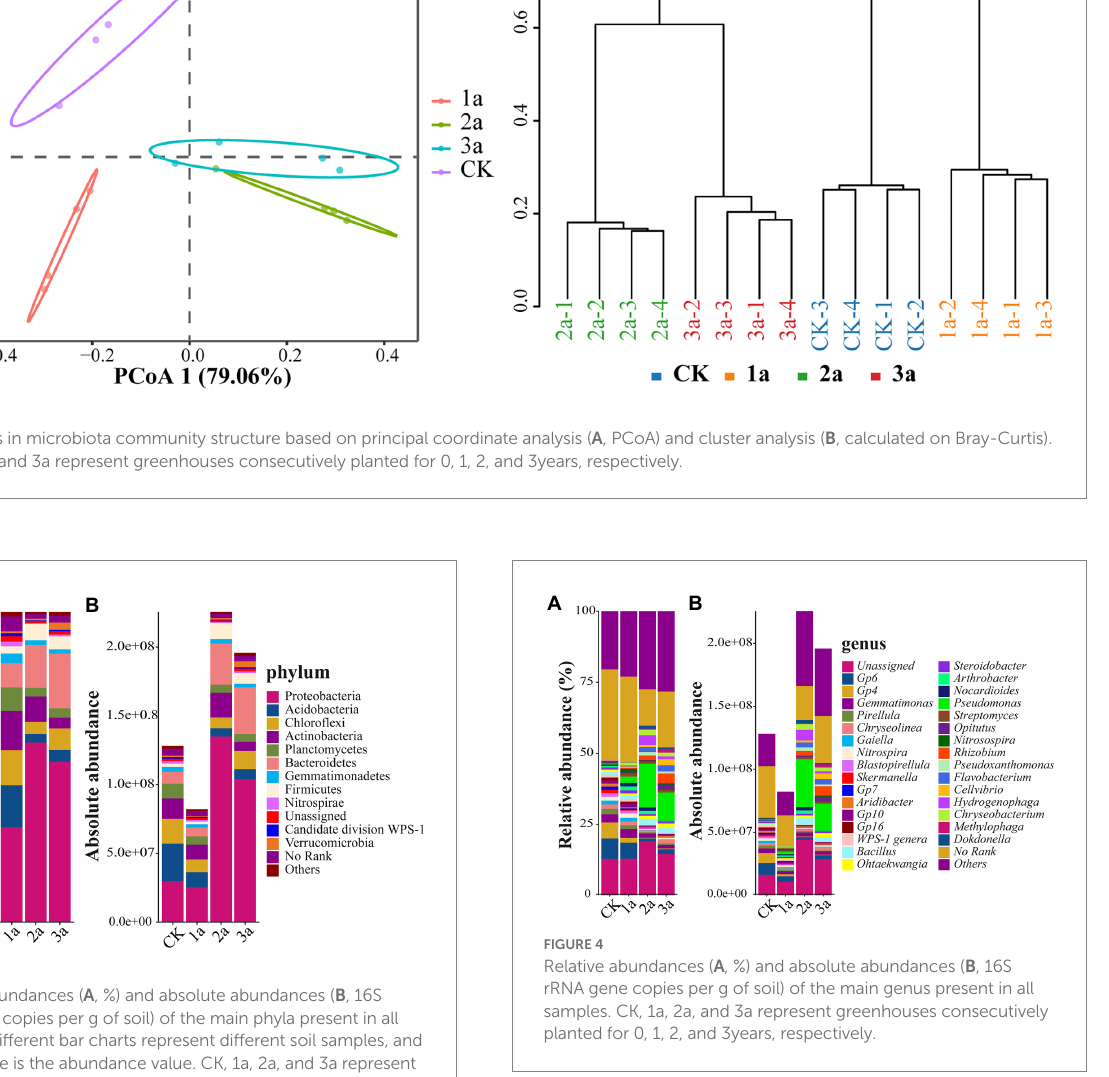
FIGURE 4 Relative abundances ( A , %) and absolute abundances ( B , 16S rRNA gene copies per g of soil) of the main genus present in all samples. CK, 1a, 2a, and 3a represent greenhouses consecutively planted for 0, 1, 2, and 3 years,